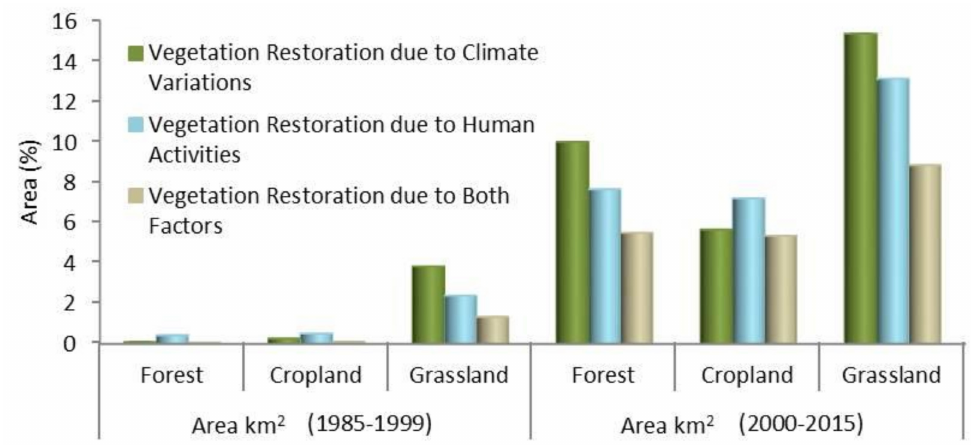
Figure 10. Relative contributions of climate and human activities for NPP restoration of three vegetation classes.